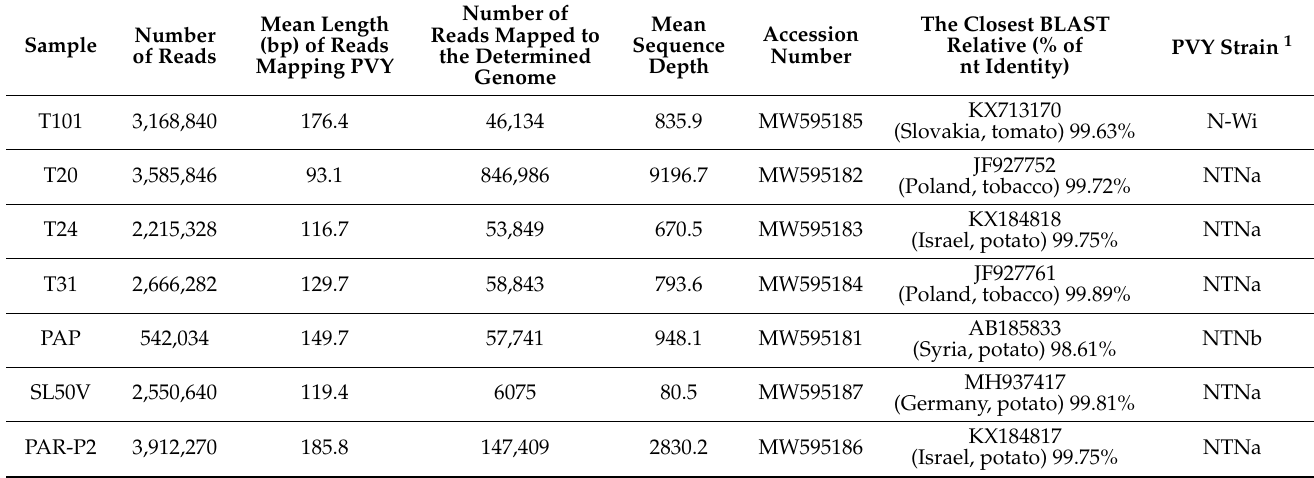
Table 2. Analysis of HTS data from the samples containing only one detectable PVY sequence